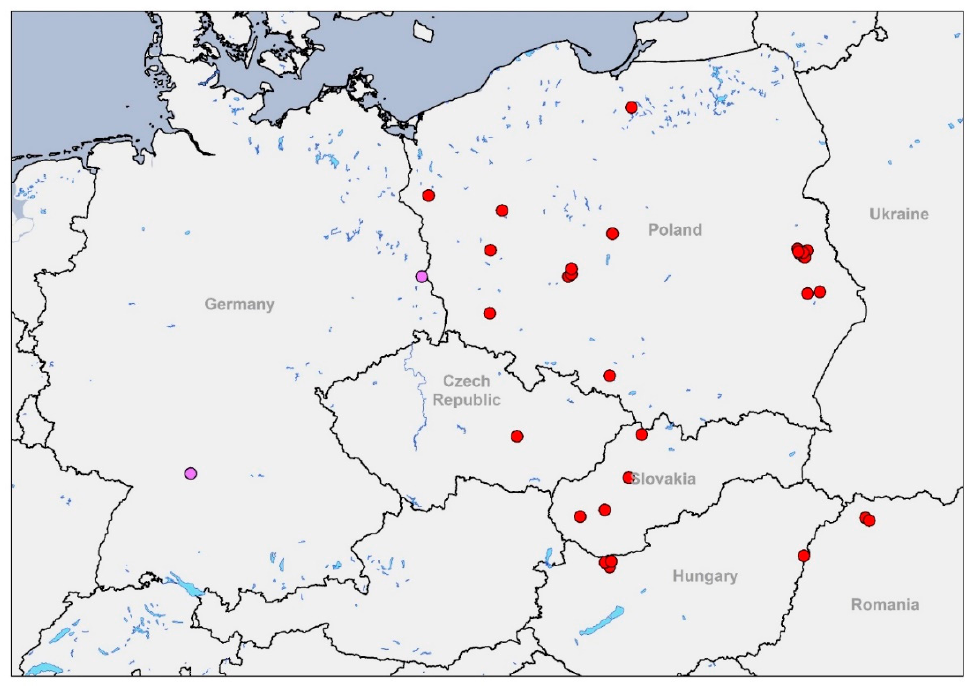
Figure 1. Geographical distribution of European HPAIV H5N8 detections from December 2019 to February 2020 (status as of 13 February 2020). The two German cases are highlighted in purple. Maps were plotted using data from the OIE website and the German animal disease notification system (TSN).